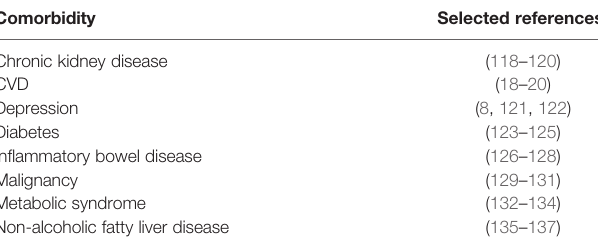
TABLE 1 | Comorbidities associated with